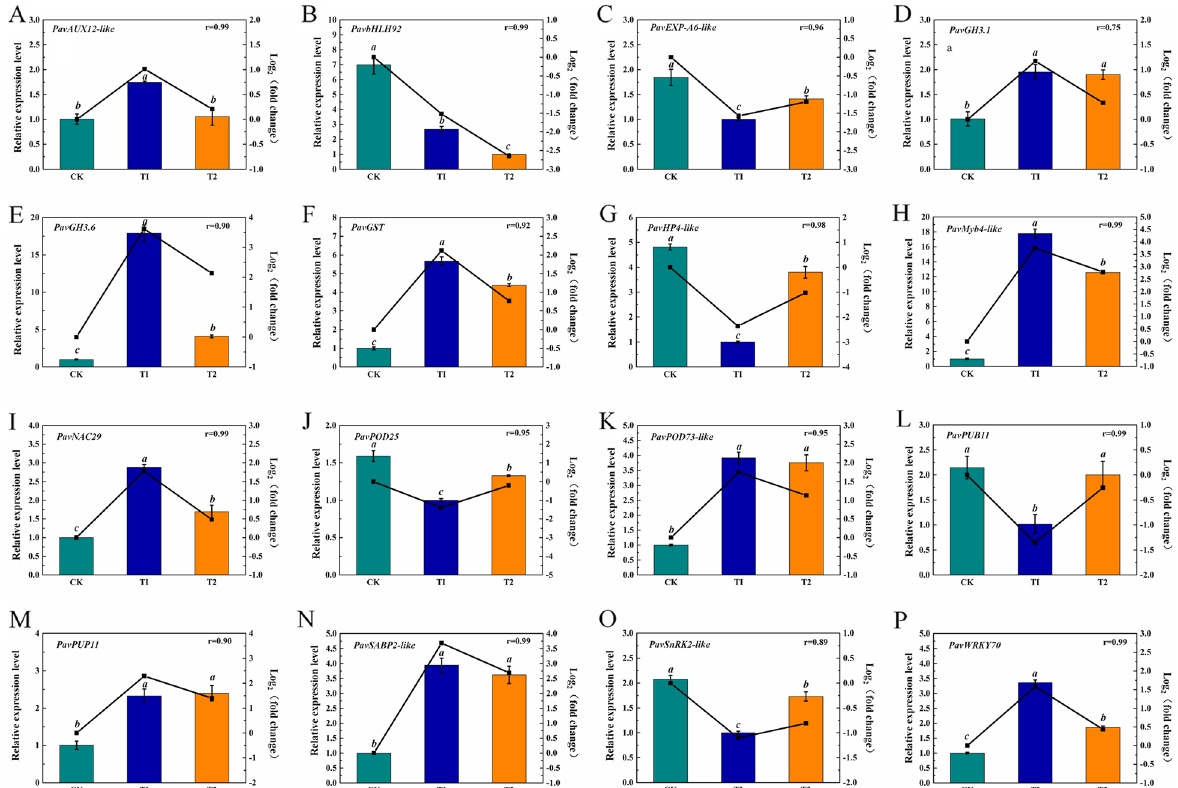
Fig. 12 Quantitative reverse-transcription PCR (qRT-PCR) validation of gene expression levels of 16 selected DEGs related to hormone pathways and stress associated transcription factors and genes. The correlation coefficient was shown in the top right corner. The data are represented as mean standard error (SE) of three replicates. Statistical significance was determined using a one-way ANOVA; significant differences among means ± (LSD, p < 0.05) are indicated by different lowercase